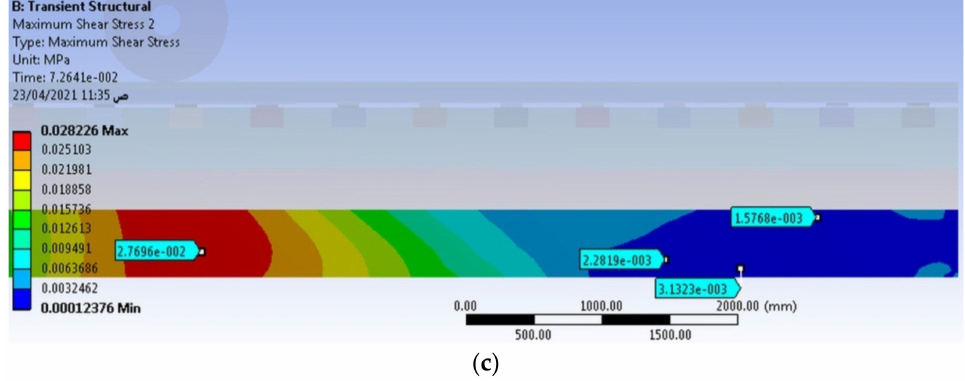
Figure 9. Stresses in the subgrade layer: ( a ) minimum normal stresses; ( b ) maximum normal stresses; ( c ) maximum shear stress. Table 4. Maximum normal and shear stresses of the selected four elements in the subgrade layer. Element No.